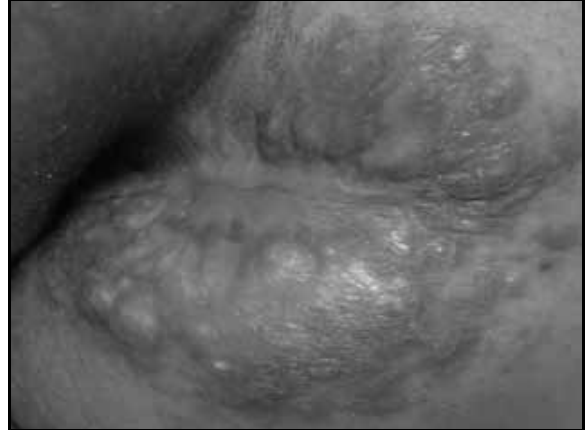
Figura 1 – Pele da região glútea direita: placa eritemato-acastanhada infiltrada com nódulos amarelados e pápulas eritemato-acastanhadas perilesionais. Nota-se